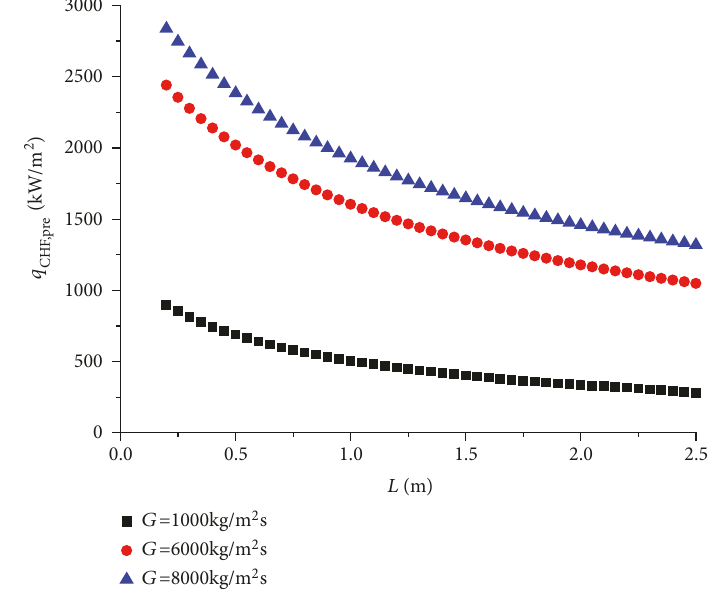
Figure 14: CHF as a function of tube length ( P =21MPa, Δℎ in =100kJ/kg,